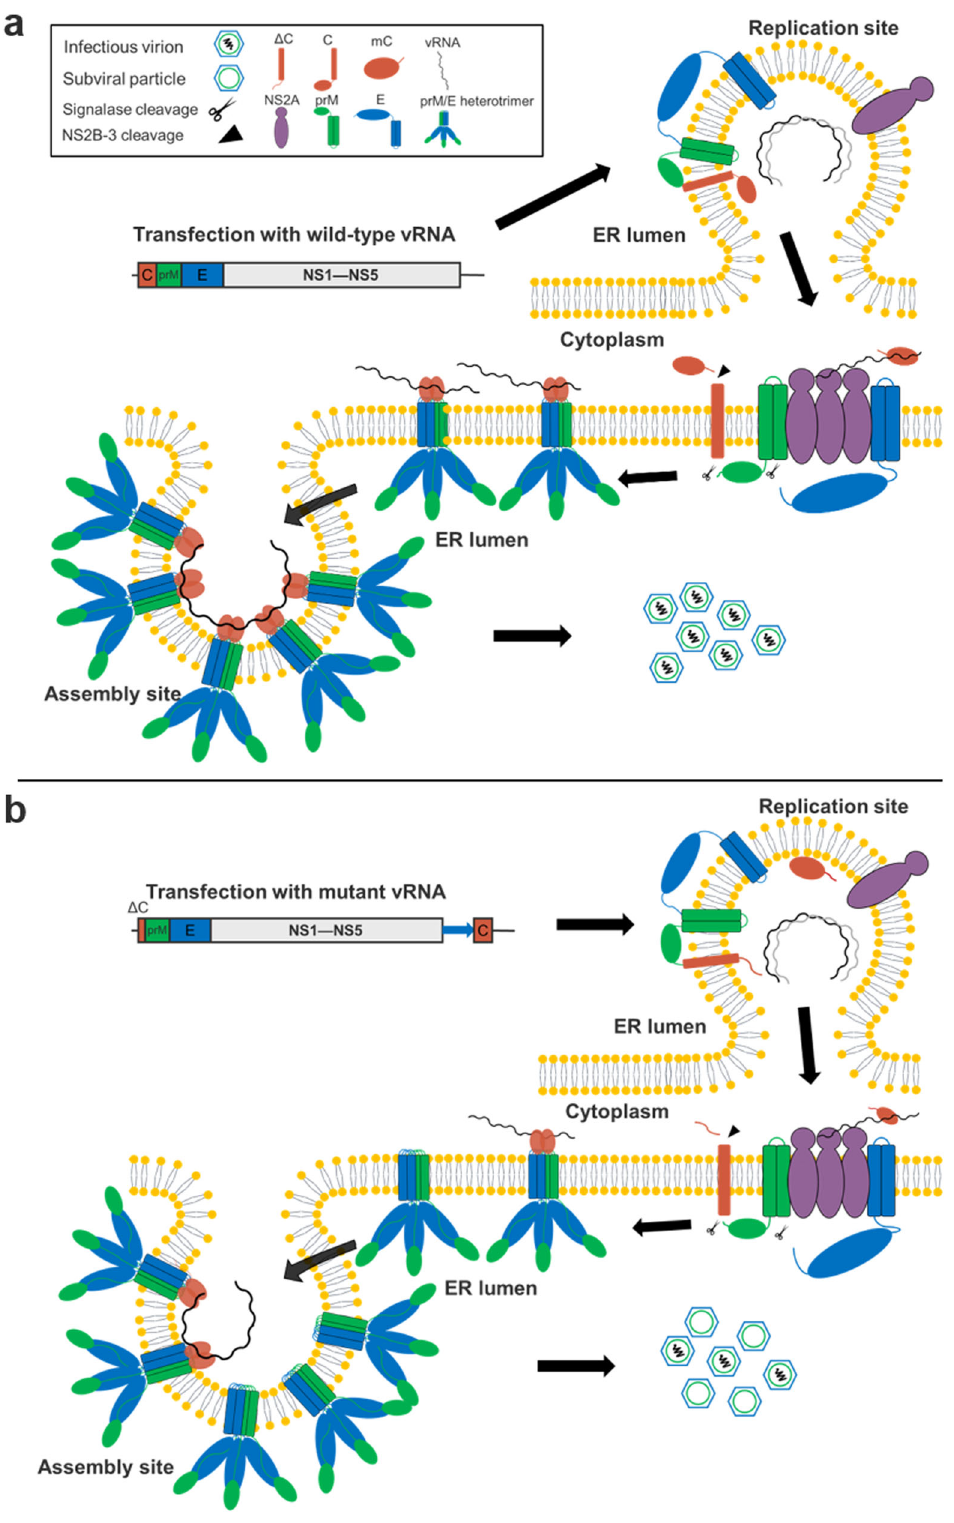
Fig. 7 Model of mutant virus ectopically expressing mature capsid protein. a Continuous cleavage of fl avivirus C-prM polyprotein based on a recently proposed model for the fl avivirus assembly process 1 . After translation, the C-prM-E polyprotein spans the ER membrane via each transmembrane anchor sequence. C-prM-E and vRNA are recruited to the assembly site by NS2A, and C-prM then undergoes continuous cleavage by NS2B-3 and signalase to prevent the secretion of subviral particles containing only prM/E. b Recombinant viruses ectopically expressing mature capsid protein. The functional capsid protein is not transported to the assembly site when prM-E is recruited by NS2A, which results in the nucleocapsid not being ef fi ciently incorporated into budding virions and secreting more